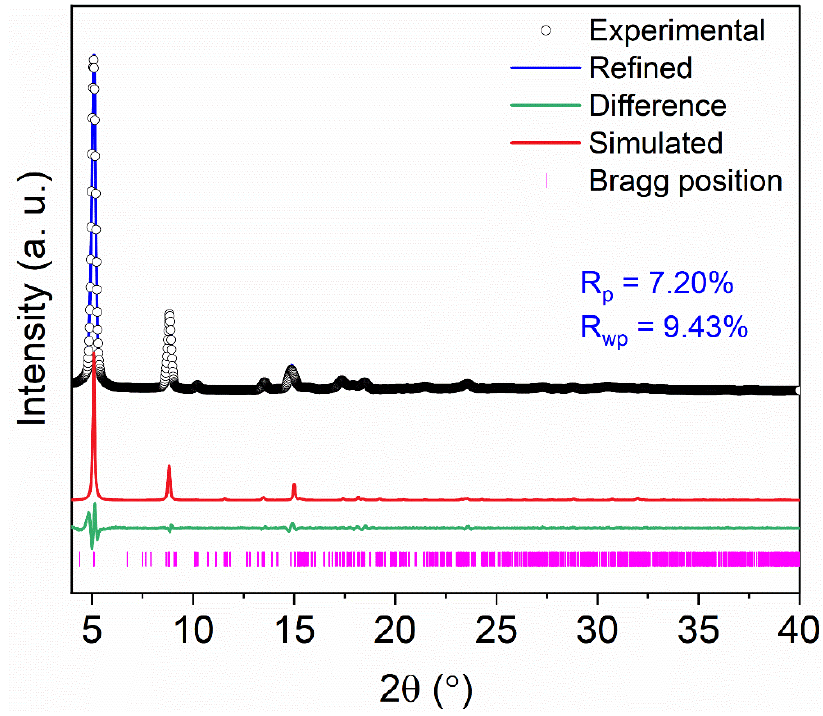
Figure 3. The PXRD analysis of NH 2 -ZSTU-2 displaying the experimental pattern (black circles), refined pattern based on Pawley refinement (blue line), the difference plot (green line), the simulated plot (red line), and Bragg positions (pink).